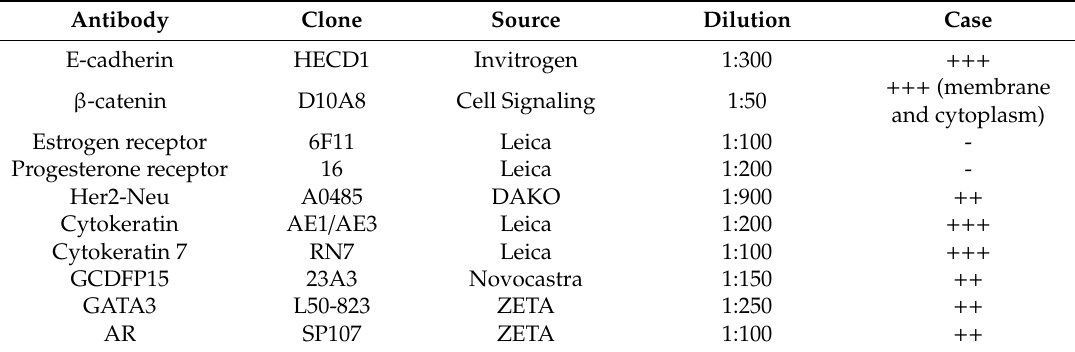
Table 1. Antibodies used in the immunohistochemical study and their results.